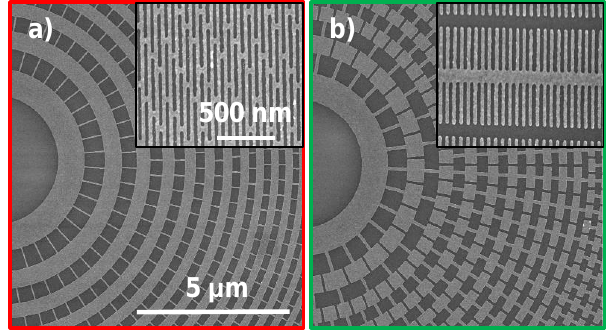
Figure 1. Top-view SEM micrographs of Au zone plate catalyst patterns on Si illustrating ( a ) brick wall (red frame) and ( b ) fishbone designs (green frame). The insets show the outermost parts of the zone plate designs. The zone plates designs have a 150 µ m diameter, 1:1 line-to-space ratio and the outermost zone widths are 30 nm. Same scale bars apply to the